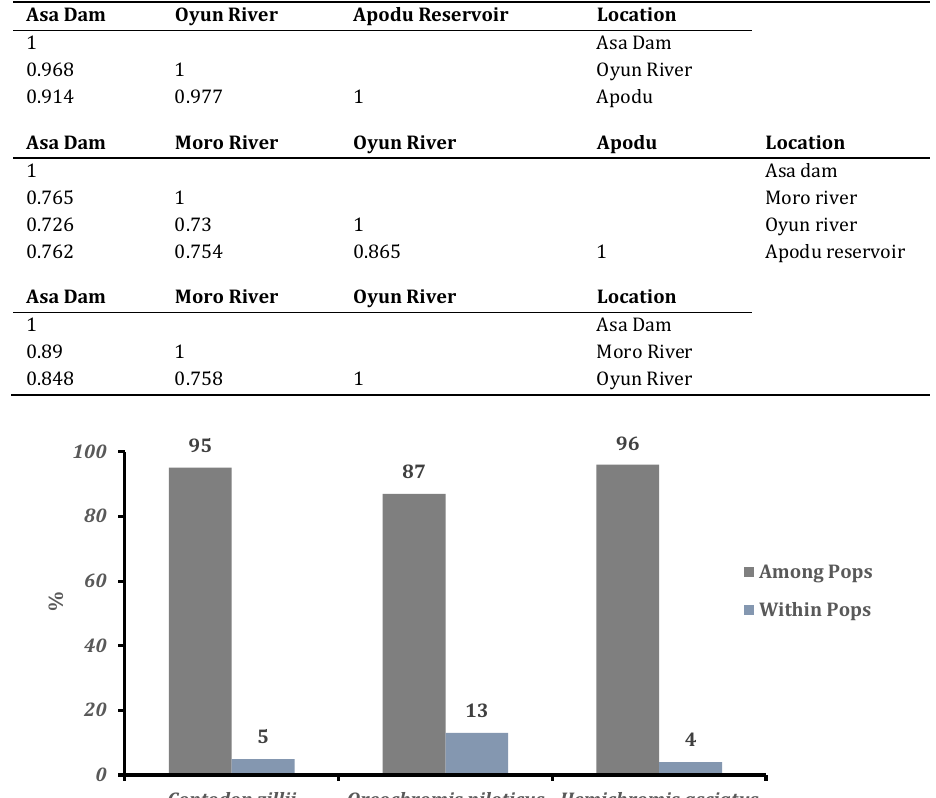
Table 3 . Pairwise population matrix of Nei unbiased genetic identity among cichlids